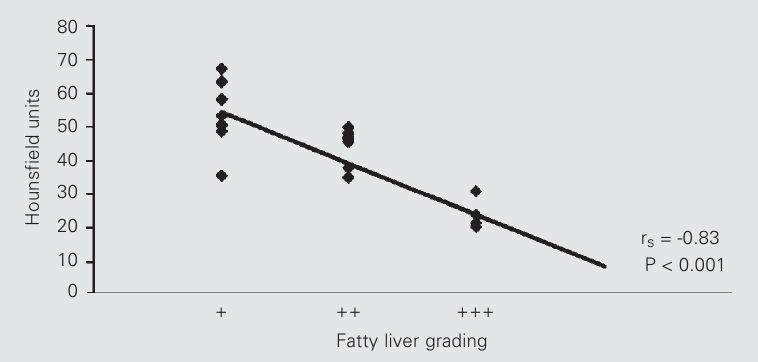
Figure 2. Correlation between computed tomography attenuation index and the histologi- cal grading of hepatic steatosis. Fatty liver was graded as described in Ref. 14: +, up to 33%; ++, 33-66%; +++,